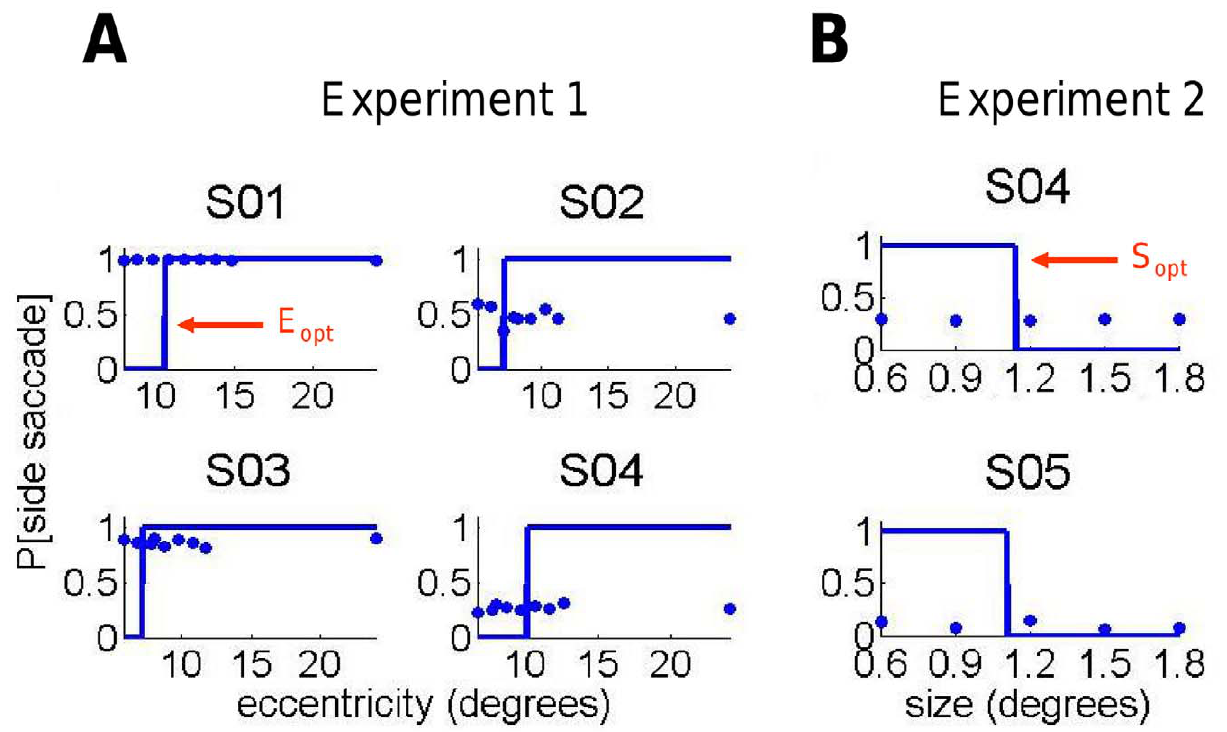
Figure 5. Strategy choice. A. Experiment 1. For each observer we plot the proportion of time they picked either the side strategy as a function of eccentricity of the side locations markers. The proportions predicted by an ideal observer maximizing probability of correct response are shown as solid blue curves. These are step functions, going from 0 to 1 at the optimal switch point for the observer which is computed from each observer’s retinal sensitivity function. Observers failed to shift strategy with changes in eccentricity. B. Experiment 2. For each observer we plot the proportion of time they picked either side strategy as a function of size of the targets.